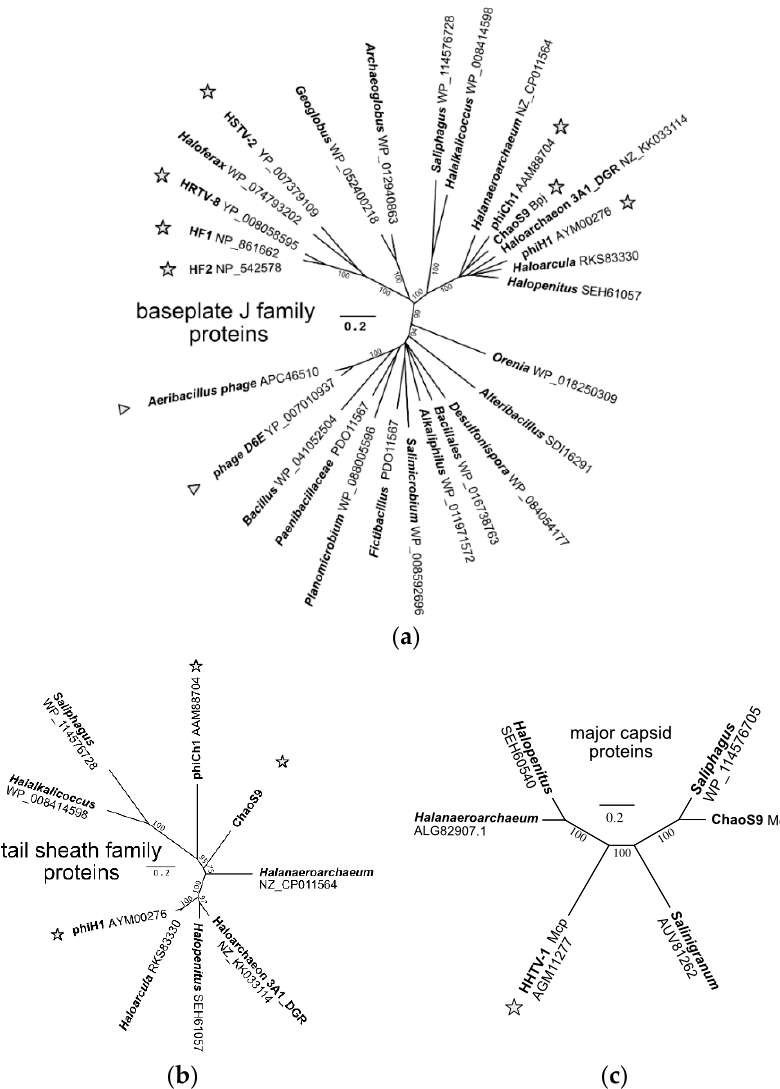
Figure 7. Phylogenetic tree reconstructions using ( a ) baseplate J family proteins, ( b ) major tail sheath proteins and ( c ), major capsid proteins. Halovirus proteins are marked by stars and bacteriophage proteins are marked by triangles. The consensus trees were produced using the Neighbor–Joining algorithm and 100 bootstrap replications. Scale bars represent the estimated number of amino acid replacements per position.